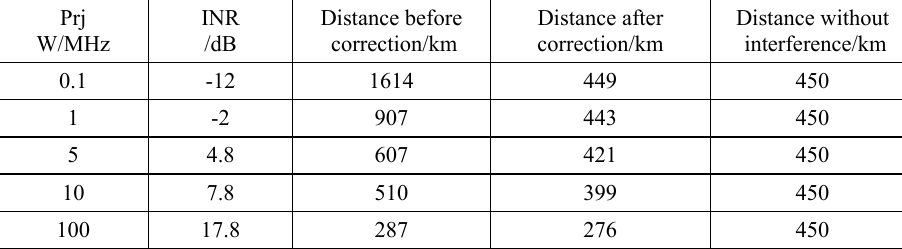
Table 2. Comparison of the radar detection distance after taking anti-jamming measures.